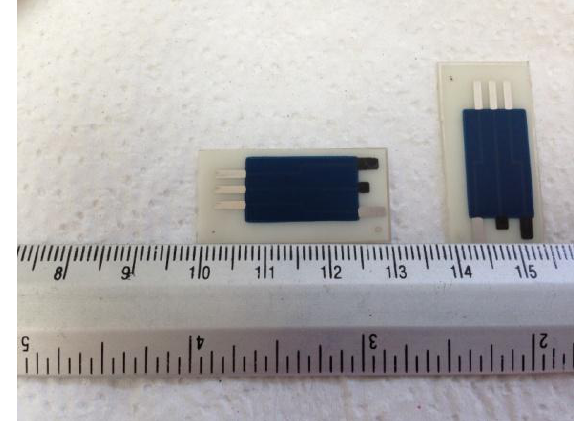
Figure 6. Dimensions of the screen printed electrode system